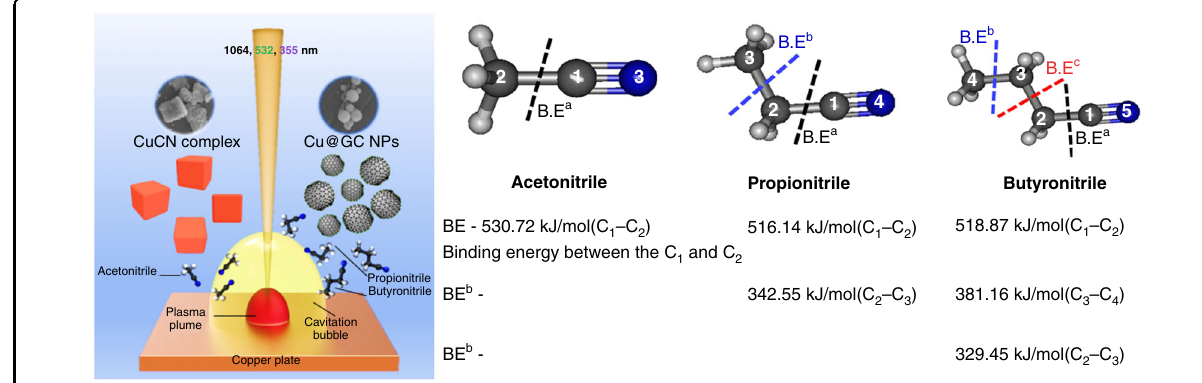
Fig. 9 Schematic illustration of the PLA of the Cu-plate in various nitrile solvents, and the structure of organic nitrile solvents with calculated binding energies 33 . Copyright (2021) Springer